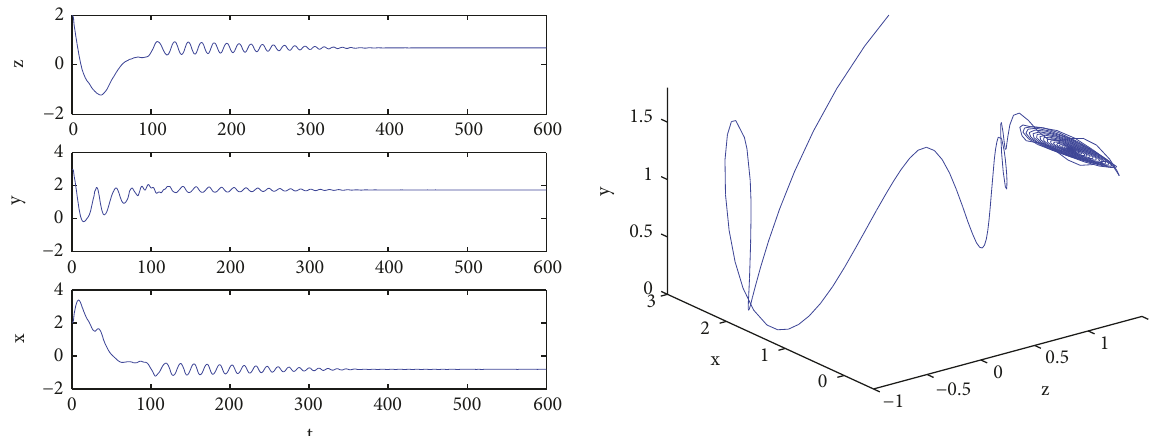
Figure 12: The equilibrium becomes stable and chaos disappears for system (52) with 𝜏 1 = 0.1,𝜏 2 = 2 , and 𝜏 3 = 0.2 .